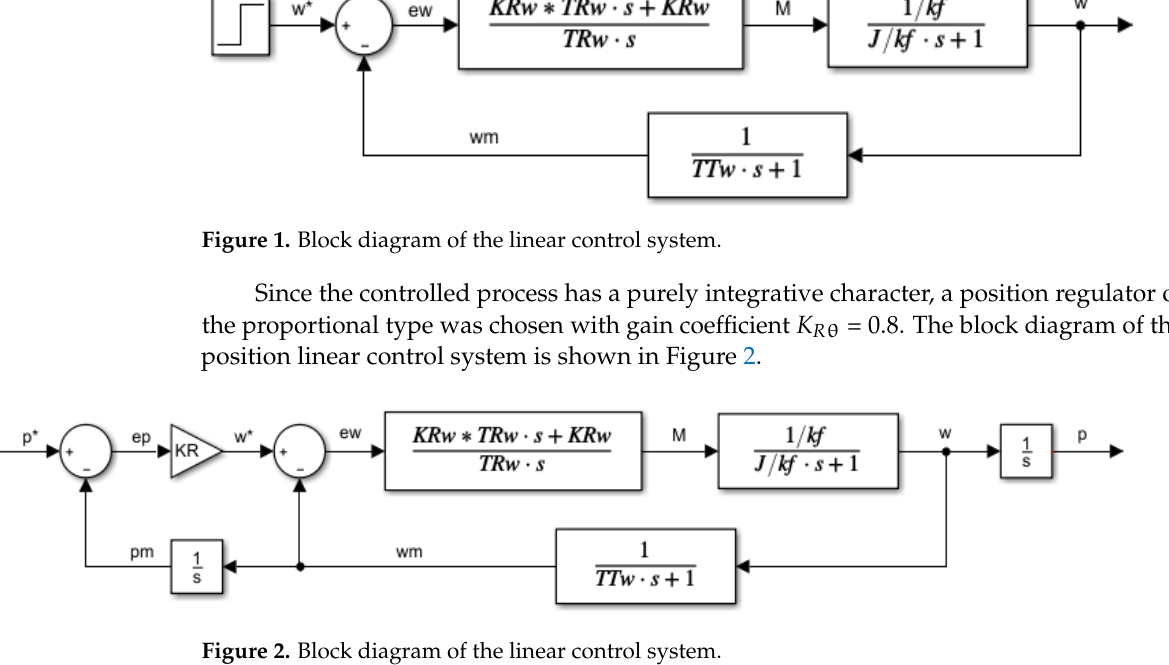
Figure 1. Block diagram of the linear control system.